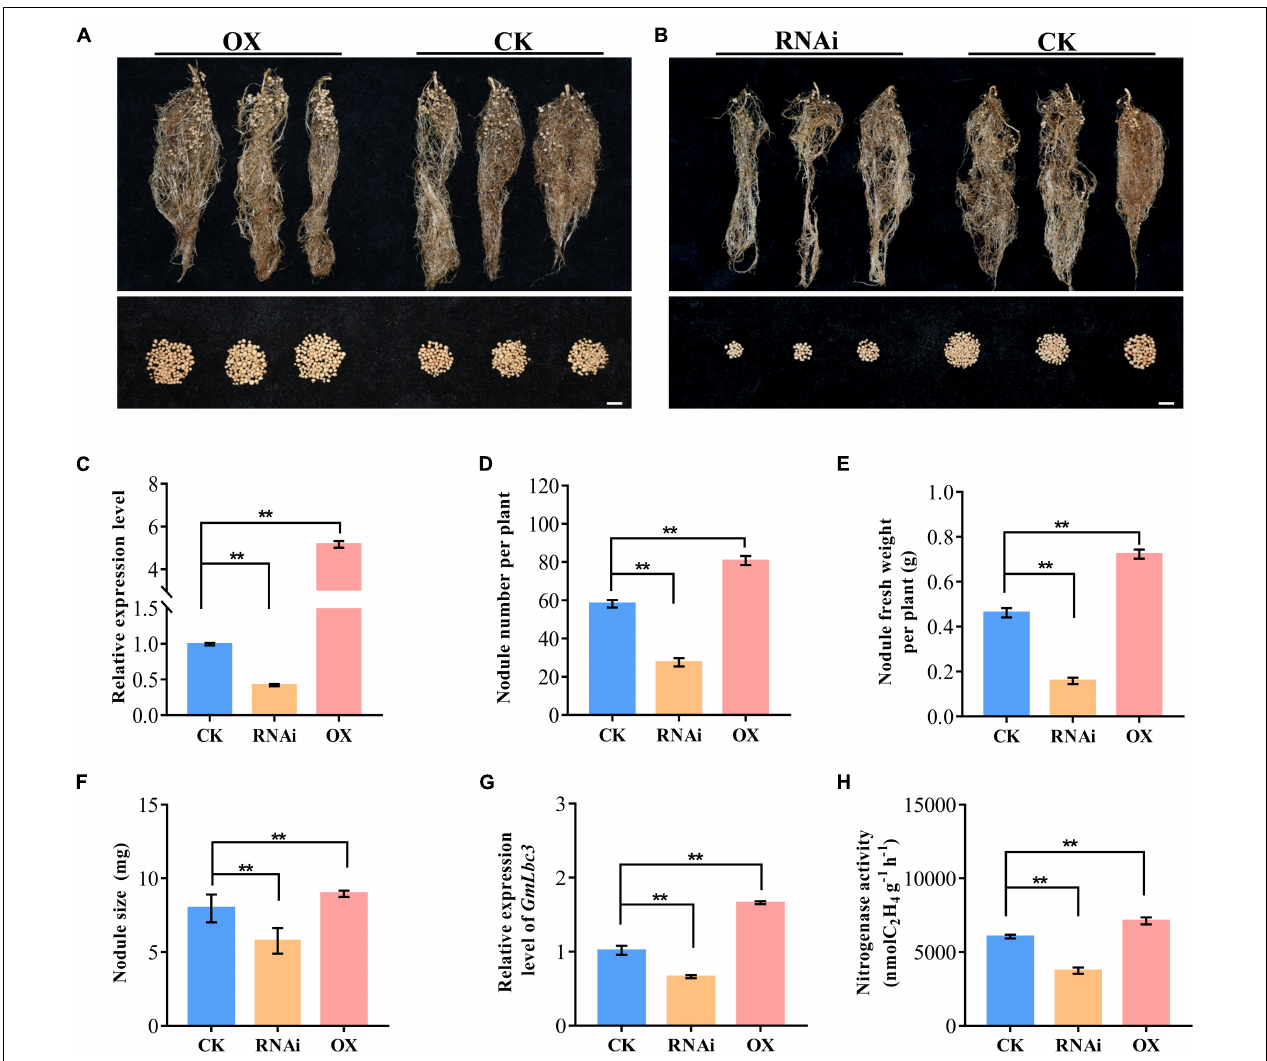
FIGURE 4 | Phenotypic analysis of nodulation of transgenic composite lines overexpressing (OX) and RNA interference (RNAi)-silenced GmHSP17.1 . (A,B) Growth performance of nodules at 28 dpi. Scale bar = 1 cm. (C) Relative expression level of GmHSP17.9 in nodules at 28 dpi. (D) Nodule number. (E) Nodule fresh weight. (H) Nitrogenase activity measured by the acetylene reduction assay. (F) Nodule size. (G) The relative expression of GmLbc3. CK refers to transgenic plants carrying empty vector. Asterisks indicate statistically significant differences according to Student’s t -test (two-tailed) (** p < 0.01), all experiments were repeated at least three times, n =